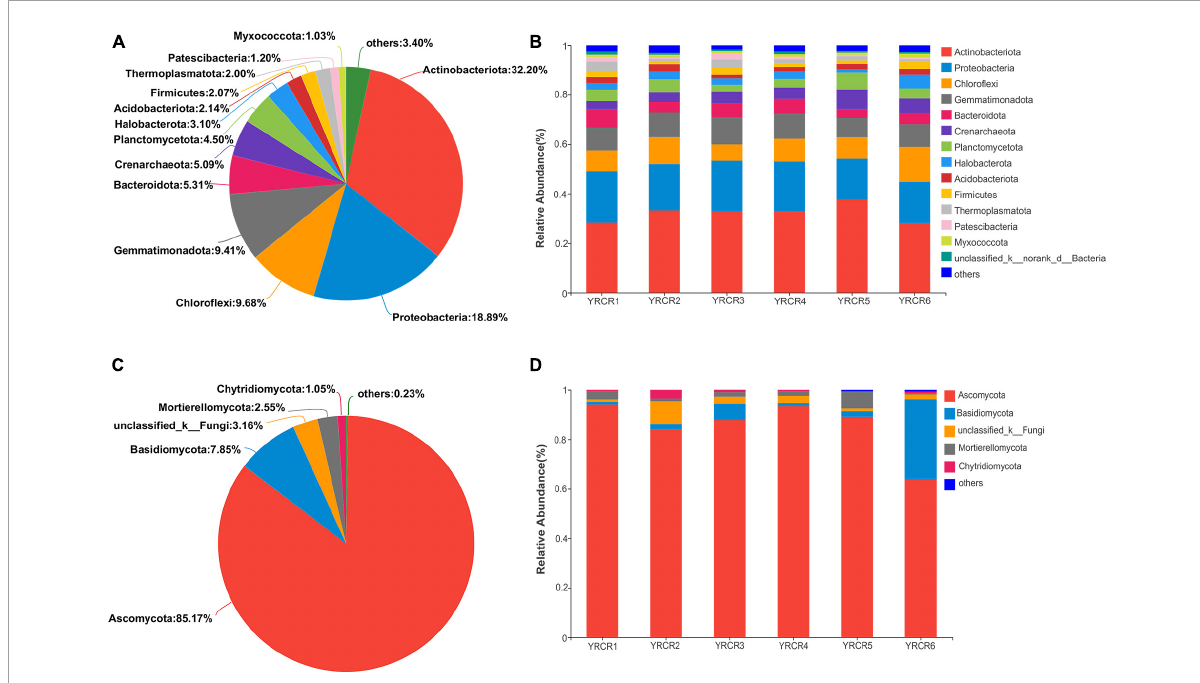
FIGURE1 (A) Is the bacterial community analysis pieplot on phylum level of all samples. (B) Is the relative abundance of bacterial on phylum level. (C) Is community abundance of fungal in all samples on phylum level. (D) Is community abundance of fungal in each sample on phylum level.